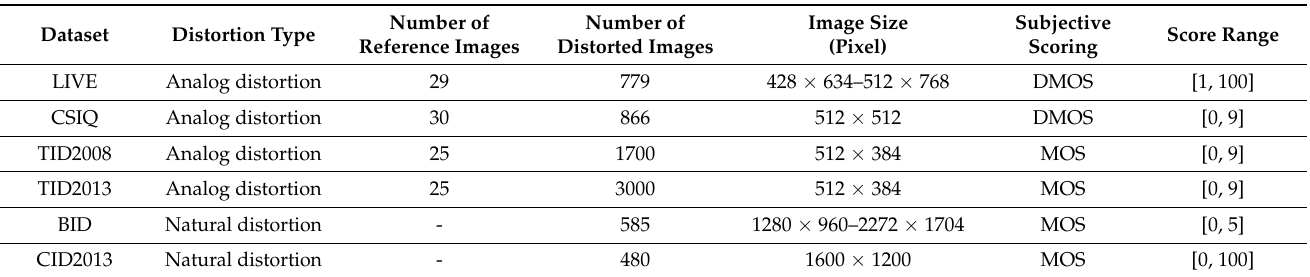
Table 4. Specific information of the public